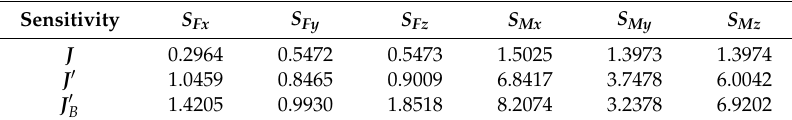
errors can be seen in Table 5. Here their relative errors are defined as Type 1 error and Type 2 error. Table 4. All the component sensitivities of the three force Jacobian matrices.